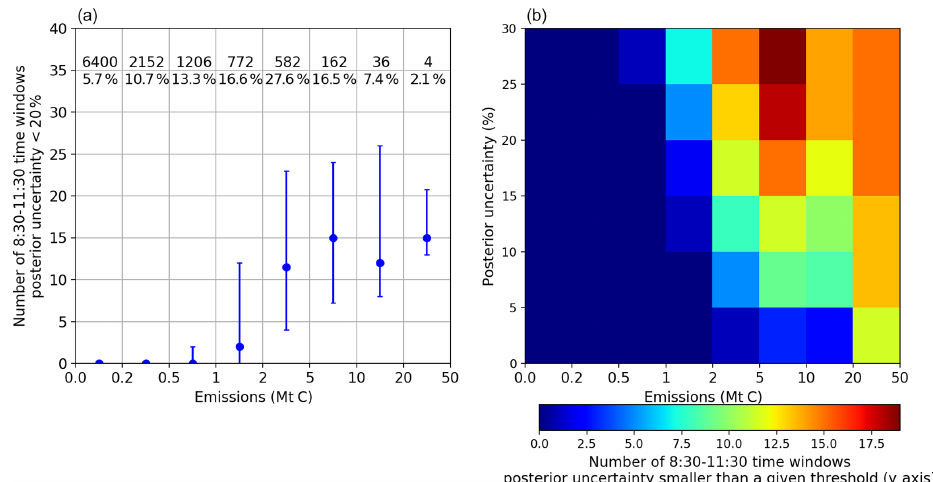
Figure 2. (a) Number of 08:30–11:30 time windows within a year for which the 3h emissions are constrained with a posterior uncertainty less than 20% (N20) in the Exp-NoCor experiment. The results are binned according to clump annual emission with bin limits given on the x axis of the figure. Dots and error bars are the median and interquartile range of N20 for all clumps within the emission bin. Numbers at the figure top indicate the number of clumps and the percentage of clump emission within each bin. (b) Number of 08:30–11:30 time windows (color) within a year for which the 3h emissions are constrained with a posterior uncertainty less than a given threshold ( y axis) in the Exp-NoCor experiment.